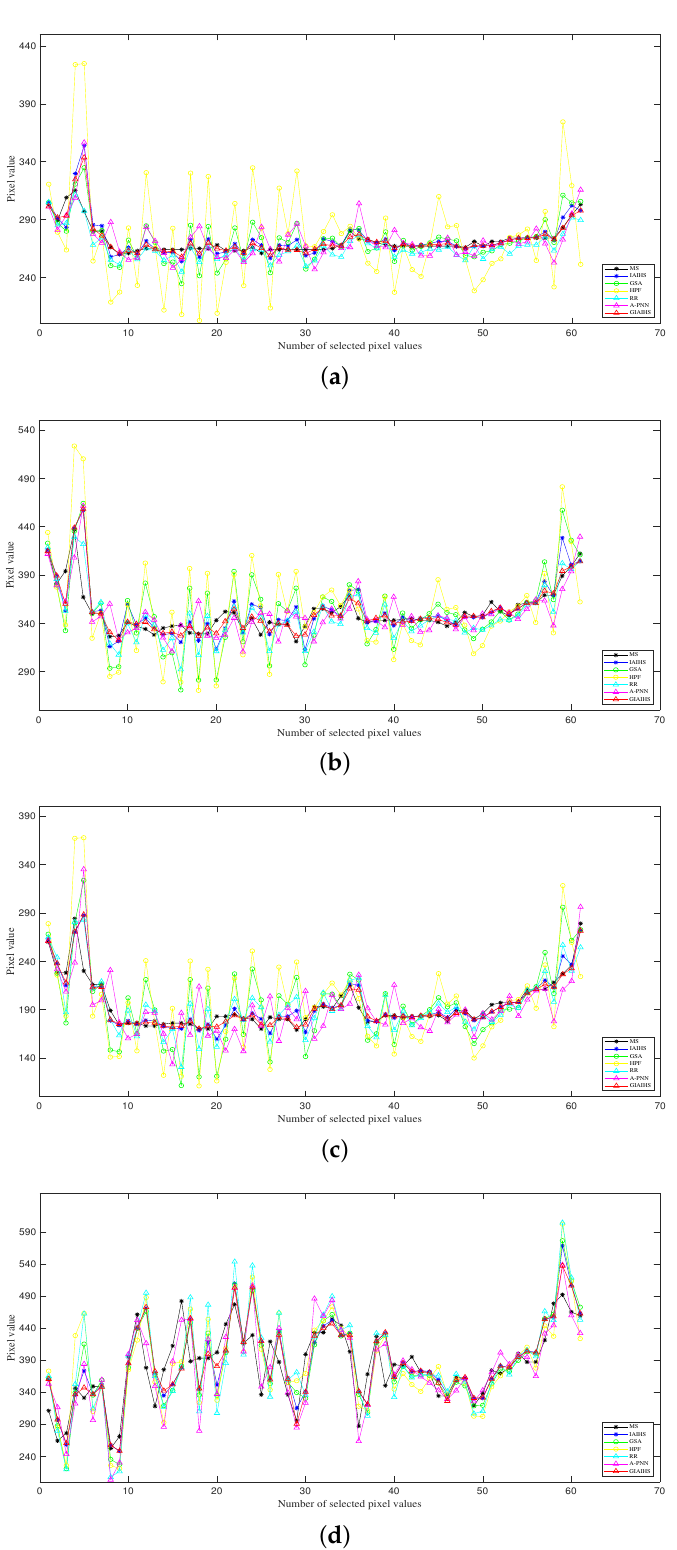
Figure 9. Results of spectral comparison and analysis of QuickBird satellite data. ( a ) R band. ( b ) G band. ( c ) B band. ( d ) NIR